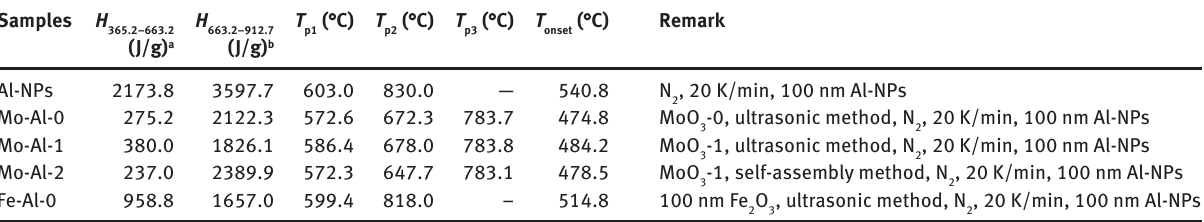
Table 1: DSC parameters of 100 nm Al-NPs and thermites. Samples H